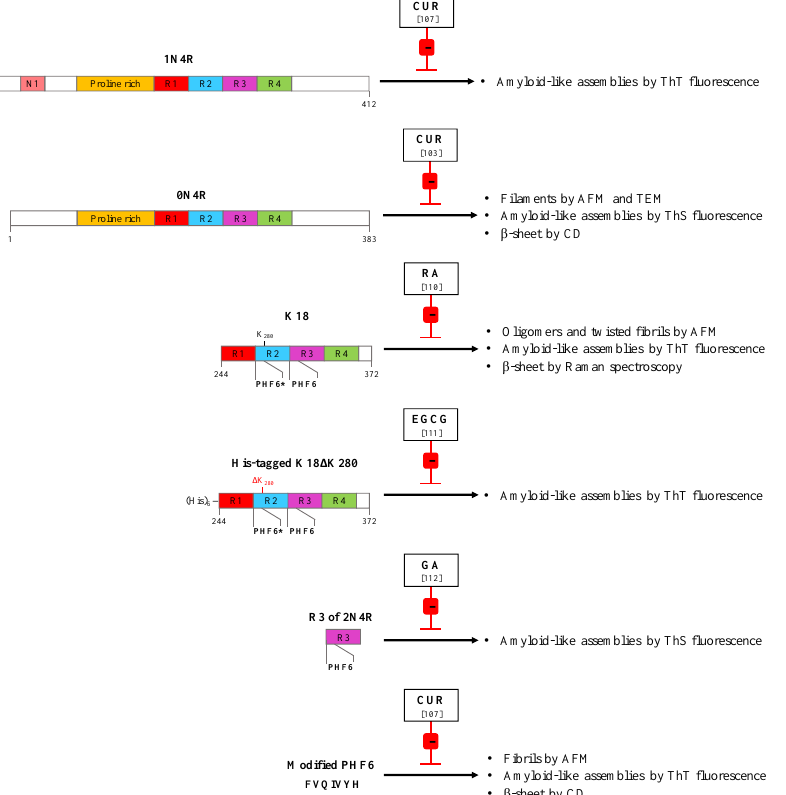
Figure 9. Polyphenols inhibit the self-assembly of full-length tau and fragments.